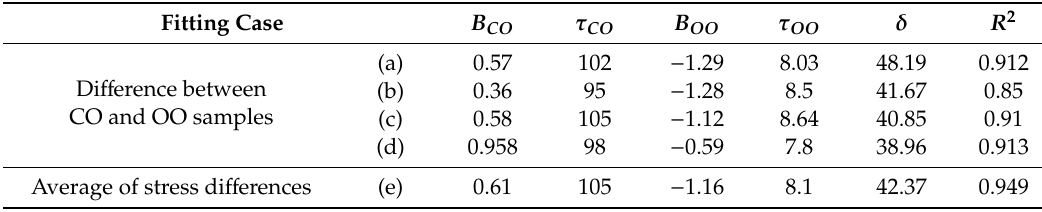
Figure 5. ( a – d ) The MCFM fit to the stress relaxation differences between some individual castor oil CIP samples and olive oil CIP samples, all tests done under 5% strain. ( e ) The MCFM fit to the average of stress relaxation differences. Table 3. MCFM fitting results.